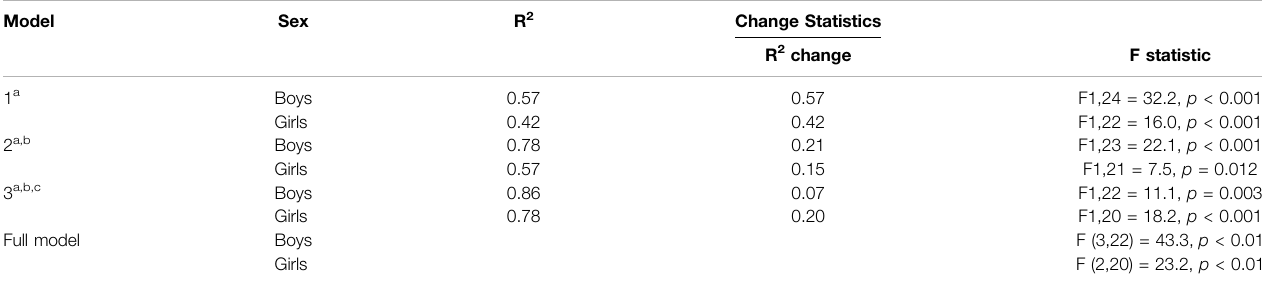
TABLE 2 | Full stepwise multiple regression analysis of V _ O 2peak (model 1), Σ O 2def (model 2), GE (model 3) for TT3min performance.